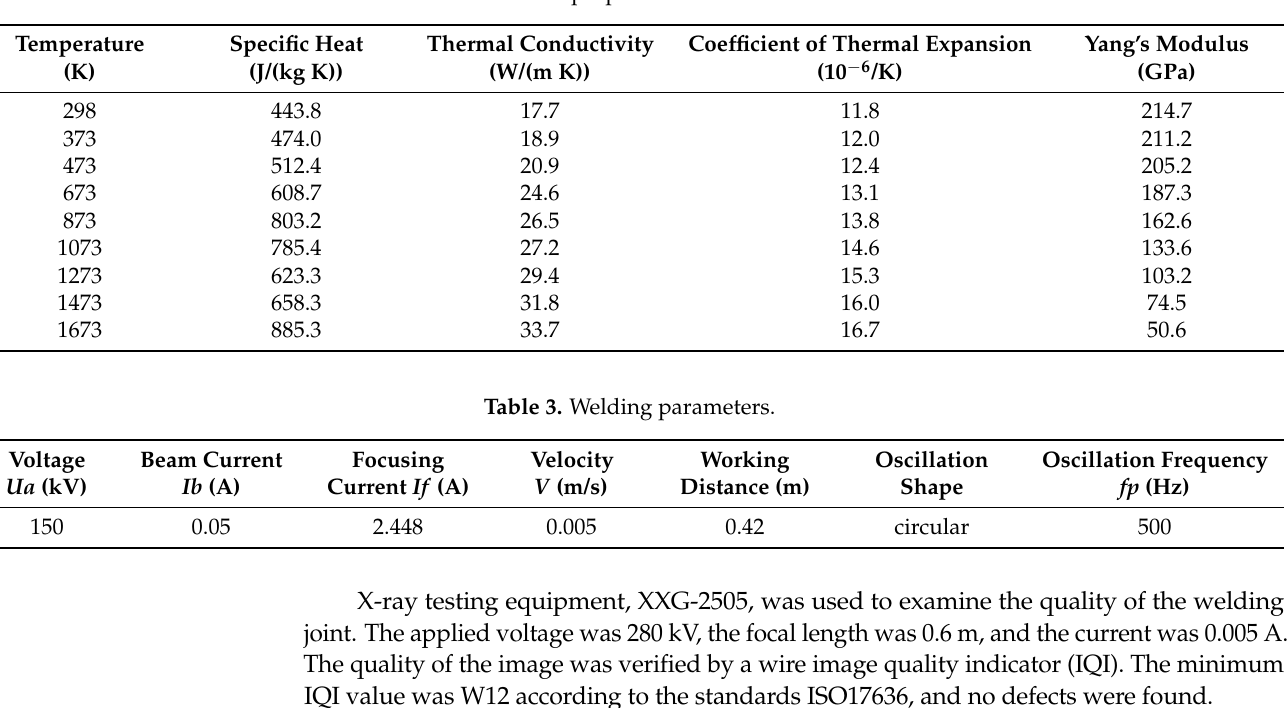
Table 2. RAFM steels properties used in the simulation.